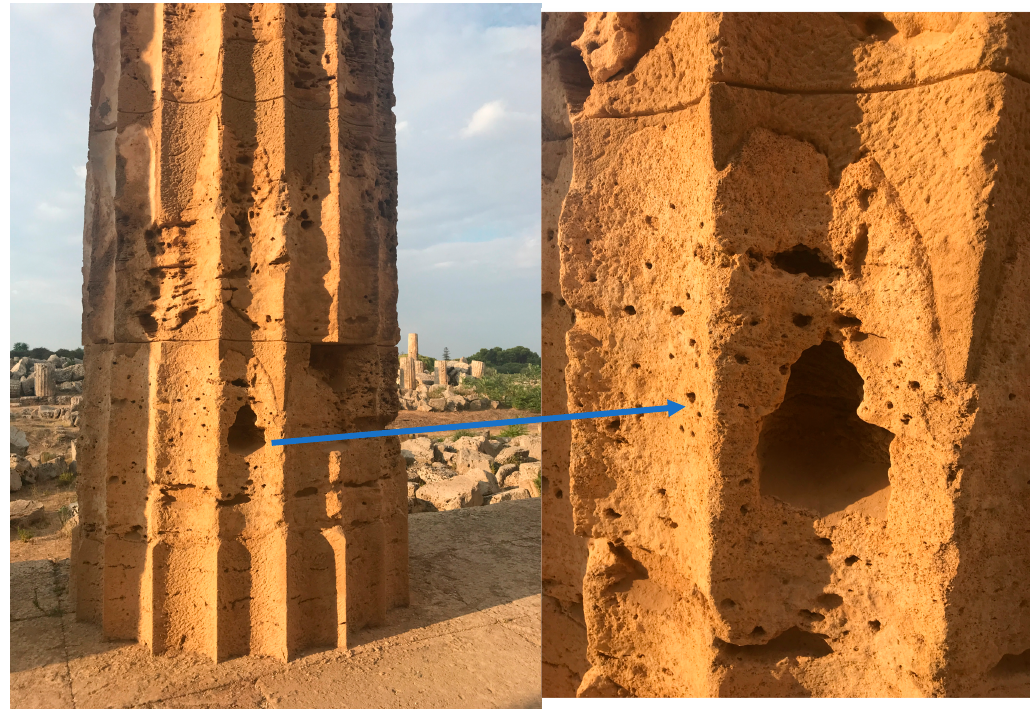
Figure 1. Salt weathering, The Temple of Hera (Temple E), Selinunte, Sicily, Italy, September 2019.